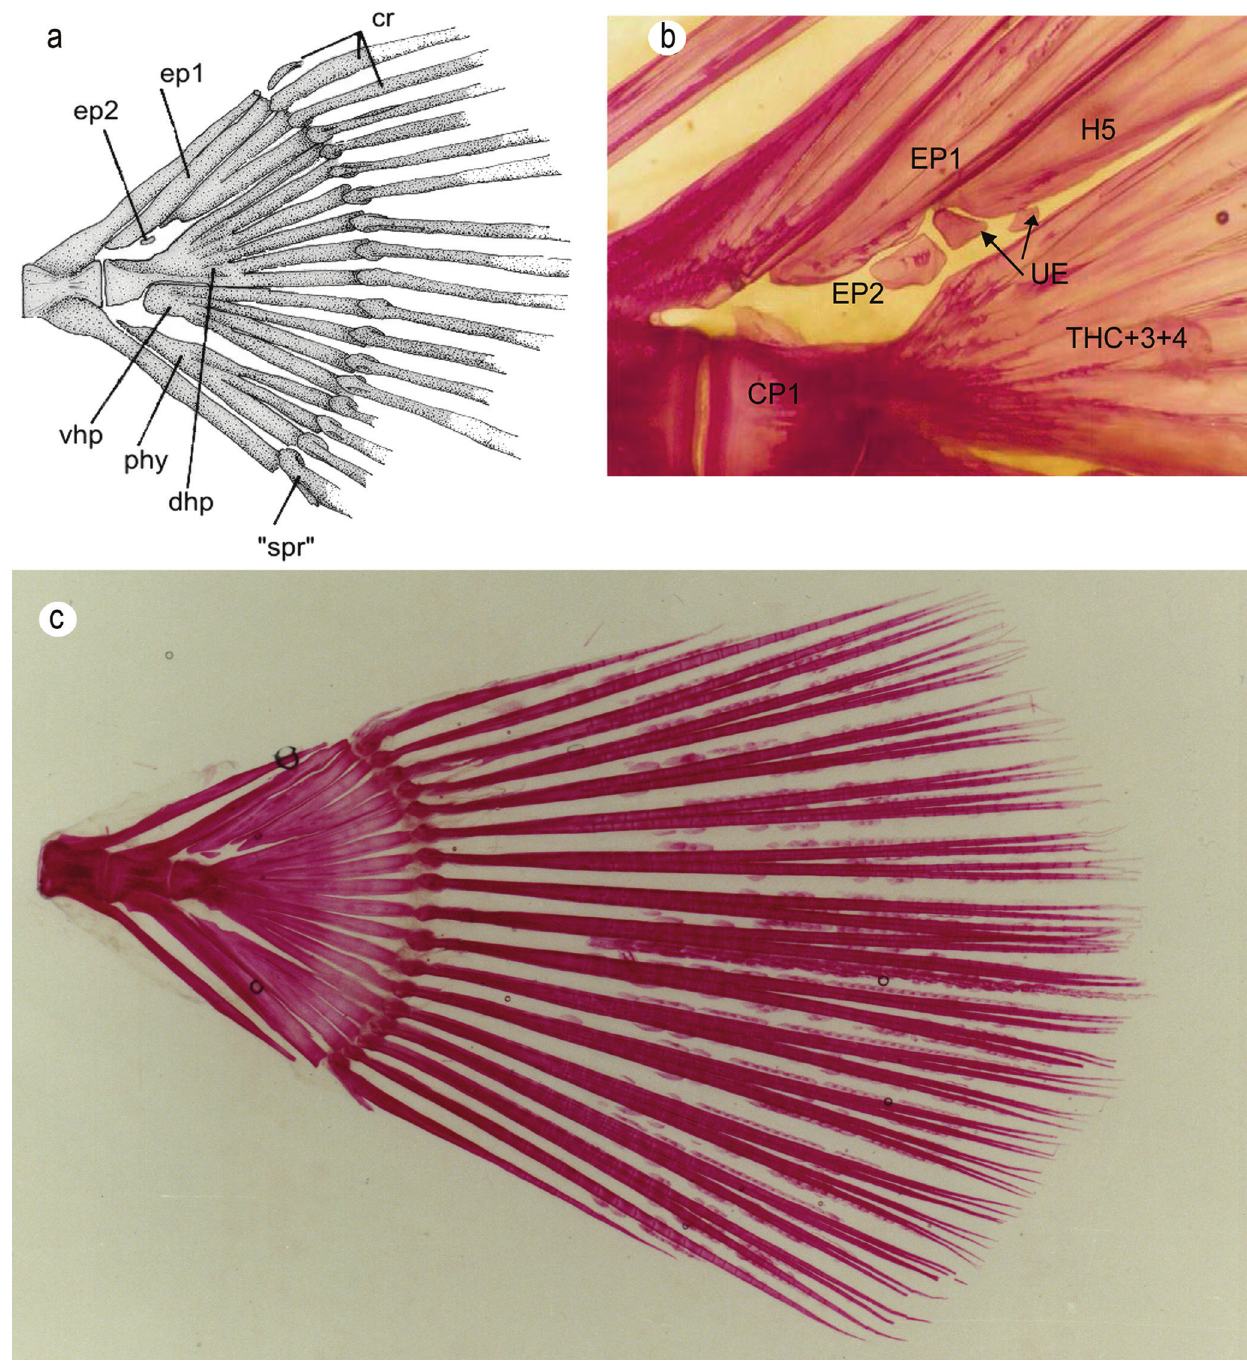
Fig. 5. Caudal skeleton of a dissected specimen of P. isosceles ( a). Cleared and stained specimens of Paralichthys patagonicus ( b ); and P. isosceles ( c ). Abrreviattions are: CP1: preural centrum 1; EP1-2: epurals 1 and 2; H1+2: ventral hypural plate; Phy: pahypural; Rca: caudal rays; “Sp.r”: “splinter ray”; H5: hypural 5; THC+3+4: dorsal hypural plate; UE: unidentified Scapula-The scapula is a flattened bony plate with a posteriorly to the scapula. The other two arise from slender caudal process. Anteriorly, the lateral surface fits the posterior border of the scapula and do not have a into a depression on the medial face of the cleithrum. facetal articulation (Fig. 6a). No differences were found Ventrally, it is connected to the coracoid by means of a among the scapulae in the three South Atlantic species of cartilaginous strip. Two of the four radials are attached Paralichthys , examined in this study.